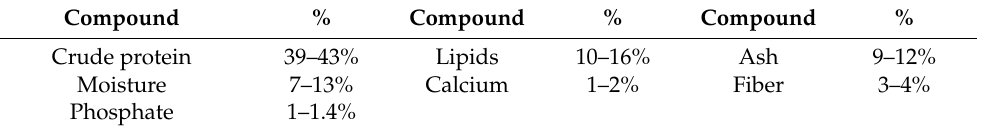
Table 2. Composition of the commercial extruded food used as acclimation diet